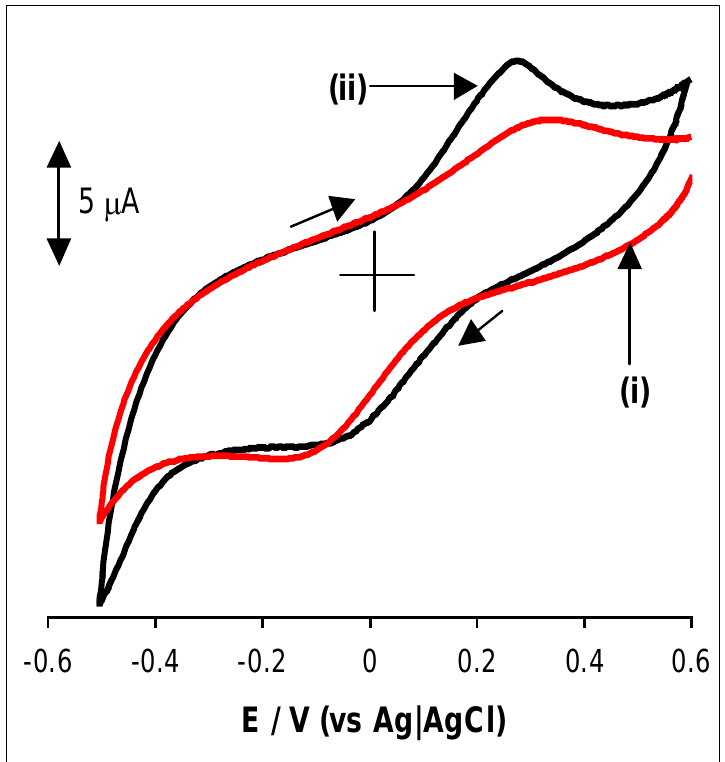
Figure 3: CV response of (i) GCE and (ii) GCE-CoPc-(CoTPP) KCl containing equimolar mixture of K